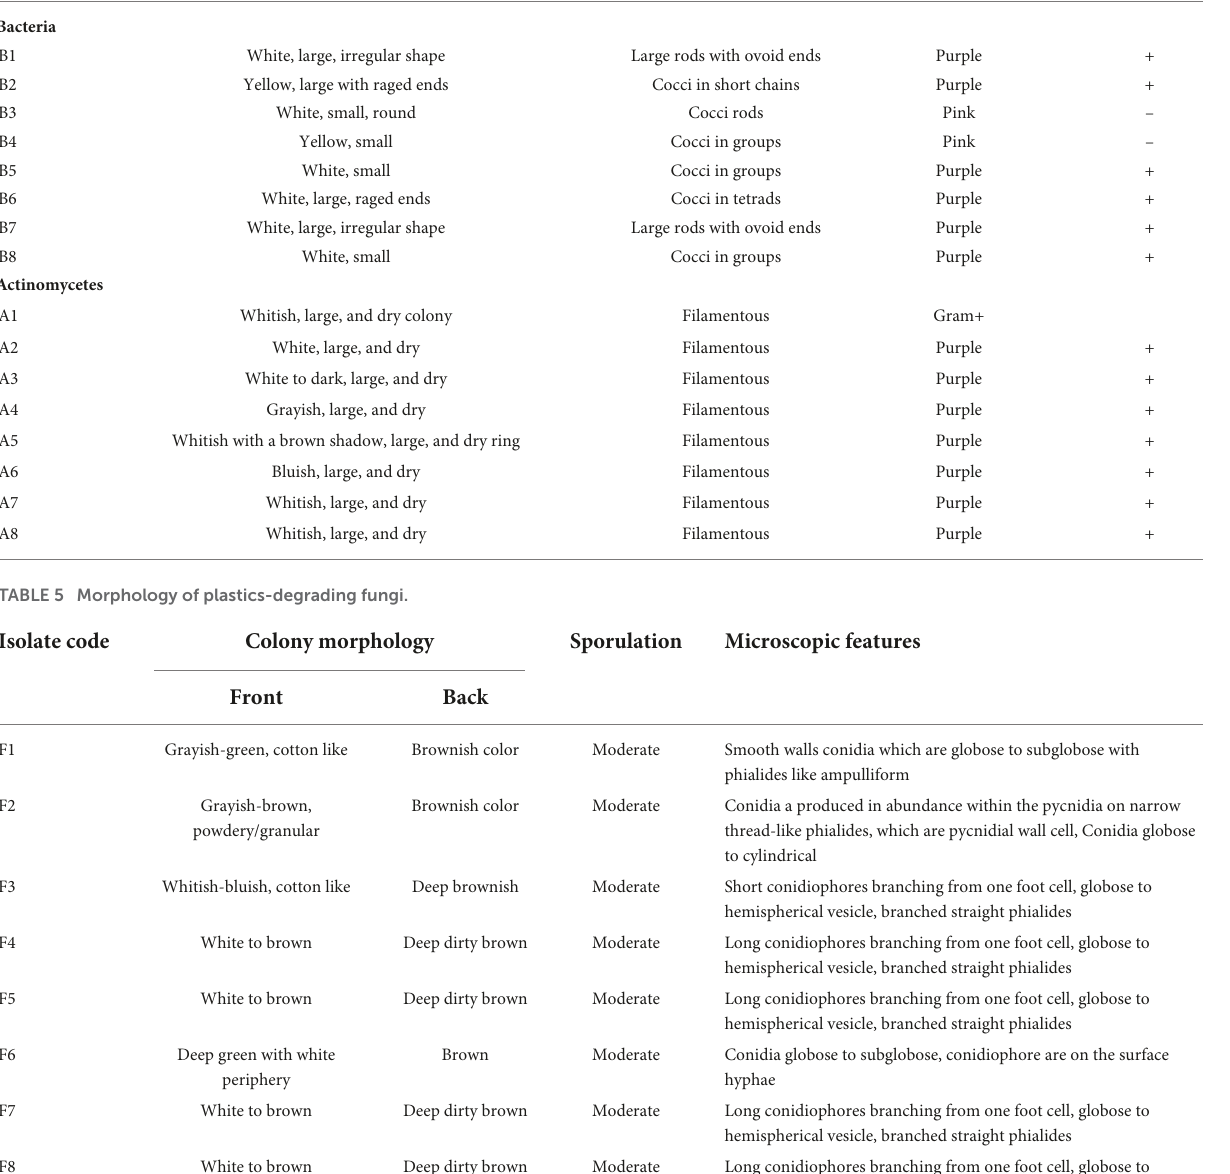
TABLE 4 Morphology of plastic-degrading bacteria and actinomycetes. Isolate Bacteria